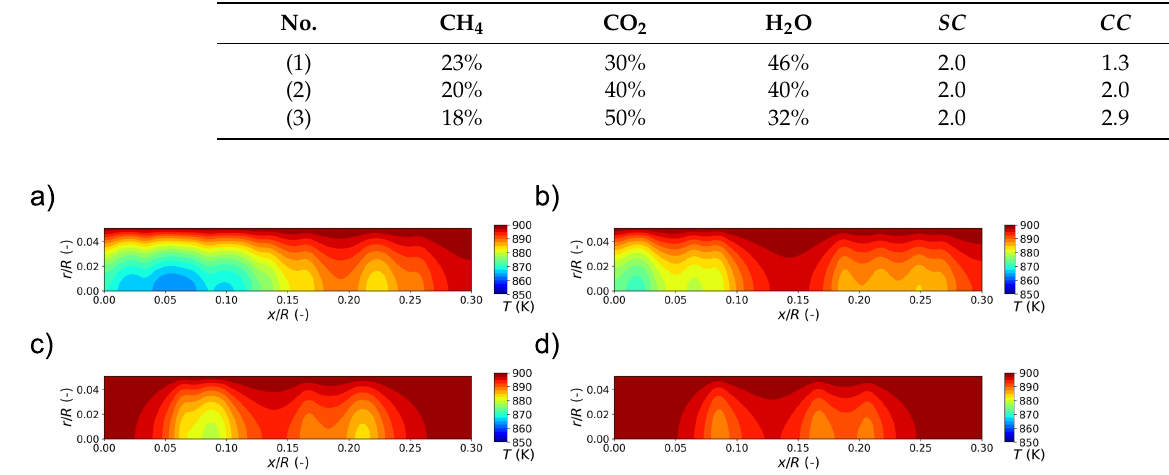
Figure 5. The temperature distribution for biogas composition (1): ( a ) initial, composition (1), ( b ) 10th gen., ( c ) 20th gen., ( d ) 30th